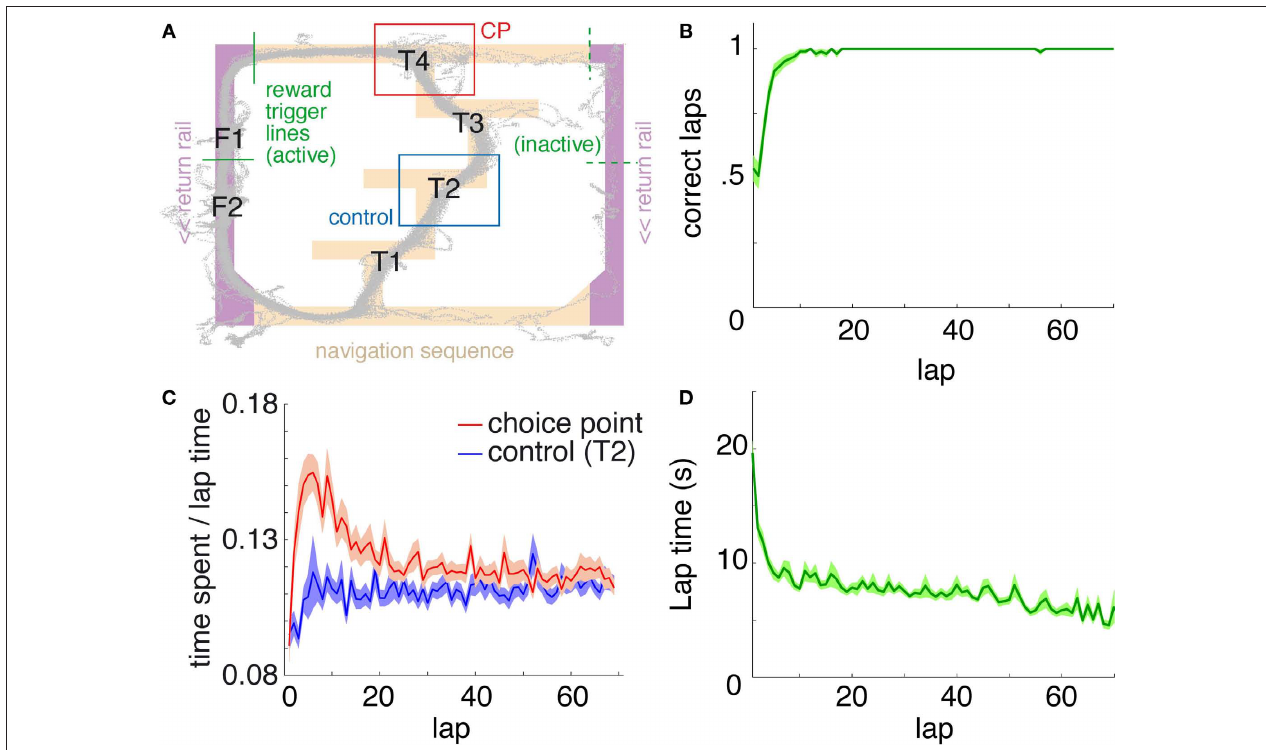
the rewarded side [green line in panel (A) ]; an error lap was defi ned as entering the equivalent region on the unrewarded side. (C) Time spent at the CP [red line, red box in panel (A) ] normalized by lap time is increased during early, but not late laps, as compared to a control area [blue line, blue box in (A) ]. Lap times (D) are computed as the time taken from entering the navigation sequence [light orange section in panel (A) ] at the bottom of the maze to exiting it at the top. Shaded areas are S.E.M. over recording